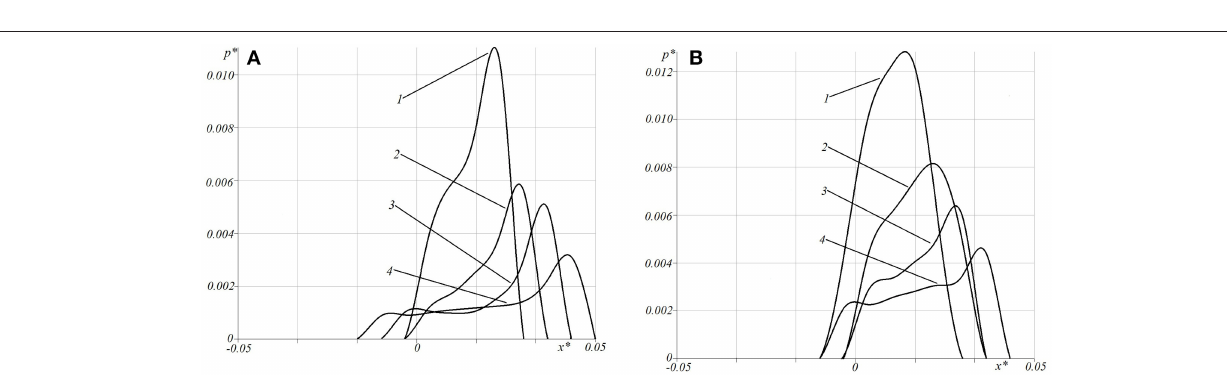
FIGURE 12 | Contact pressure distribution for different velocities and layer thickness [ c = 6; ν = 0.4; Q ′ = 2.0; V ∗ = 0.05 (A) ; V ∗ = 0.2 (B) , h ∗ = 0.05 (curve 1), h ∗ = 0.02 (curve 2), h ∗ = 0.0133 (curve 3), h ∗ = 0.0066 (curve 4)].